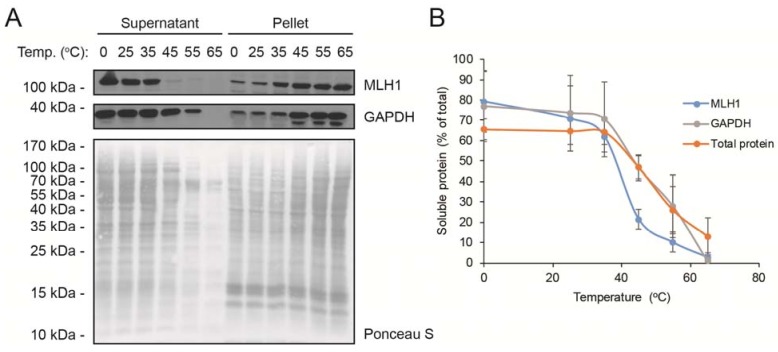
Solubility of wild-type MLH1 at a range of temperatures.(A) Transfected cells were lysed by sonication and incubated for 30 min. at the indicated temperatures. Then the lysates were separated into supernatant and pellet fractions by centrifugation. Western blotting using antibodies to MLH1 was employed to determine the amount of MLH1 in the fractions. Ponceau S staining and blotting with antibodies to GAPDH served as controls. (B) Quantification of blots as shown in panel (A) showing the amount of soluble protein (supernatant) normalized to total (supernatant + pellet). The total protein quantification is based on the full lanes of the Ponceau S stainings. The error bars indicate the standard deviation (n = 3).